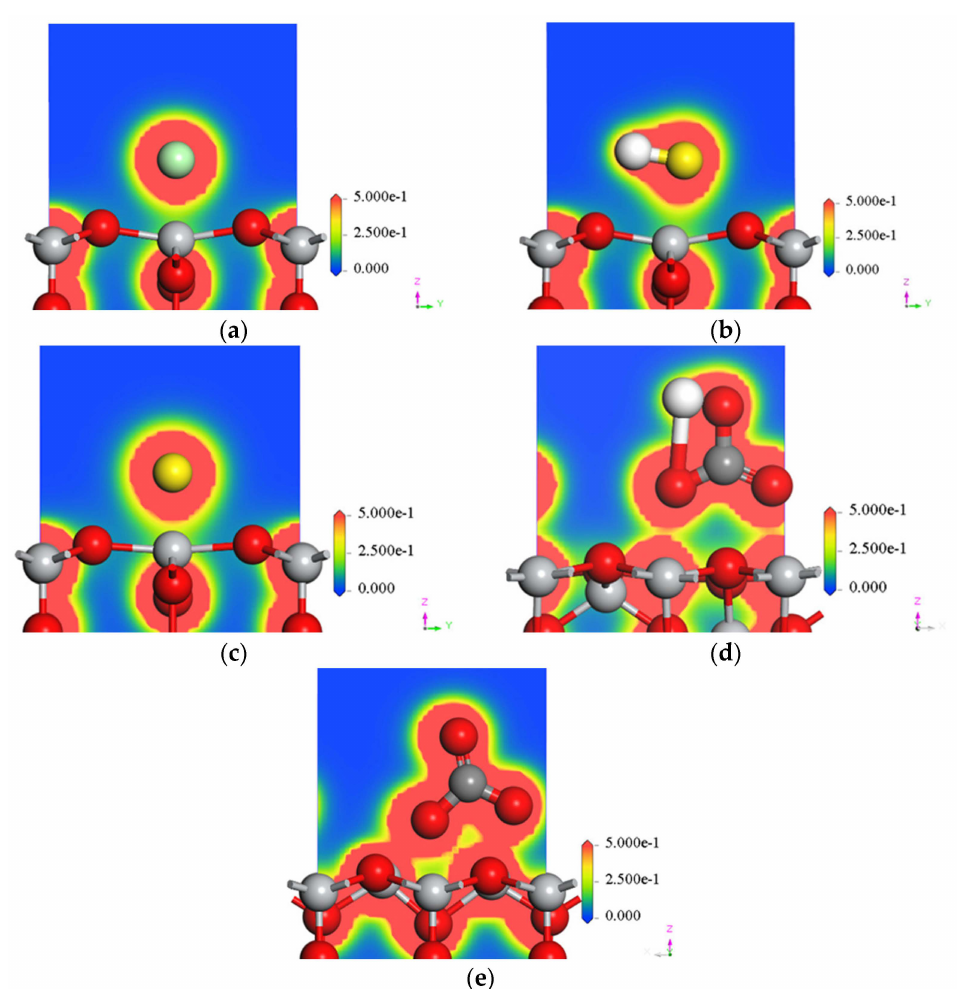
Figure 3. Charge density distribution of corrosive species at the bridge position on the TiO 2 (110) surface: ( a ) Cl − ; ( b ) HS − ; ( c ) S 2 − ; ( d ) HCO 3 − ; ( e ) CO 32 −